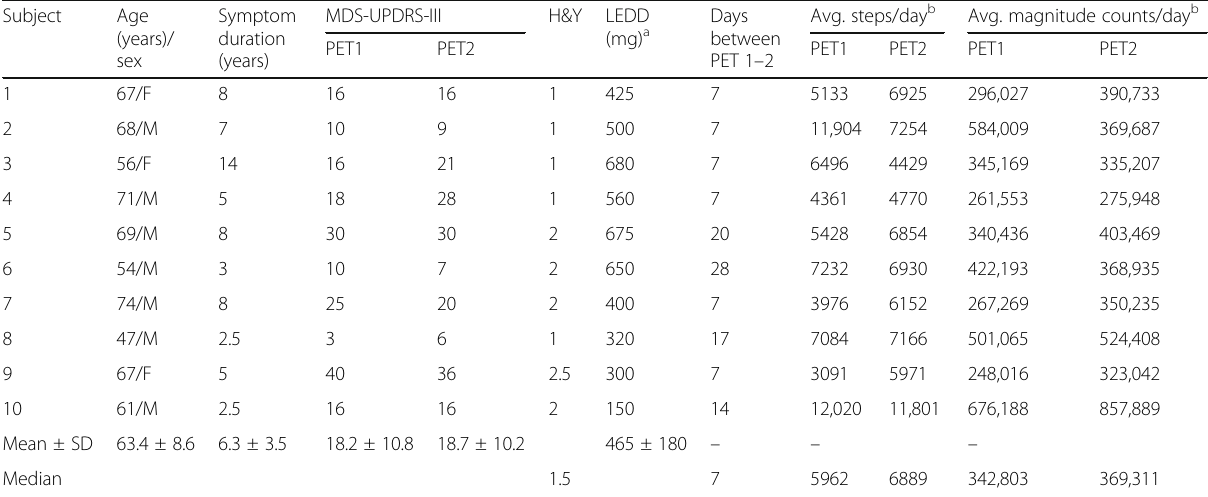
Table 1 Demographic and clinical characteristics of the